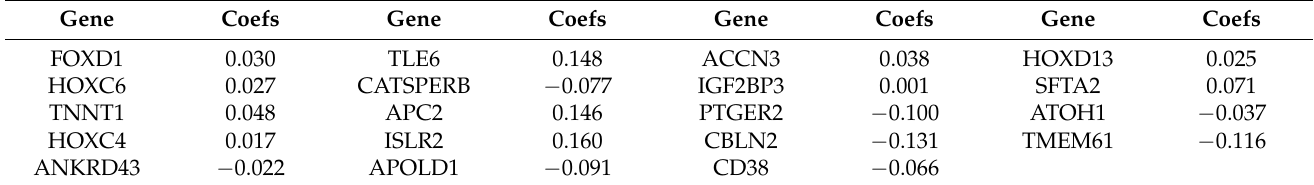
Table 1. LASSO Cox regression selected genes and coefficients.